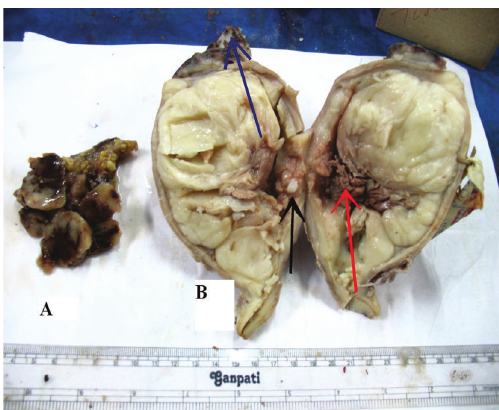
Figure 1: (a) Gross photograph of omental tissue showing haemorrhagic, necrotic fleshy mass. (b) Gross photograph of cut section of uterus showing fleshy mass distorting uterine cavity with invasion of myometrium with areas of haemorrhage and necrosis (Red arrow), bony tissue (black arrow), and subserosal nodule (blue arrow).